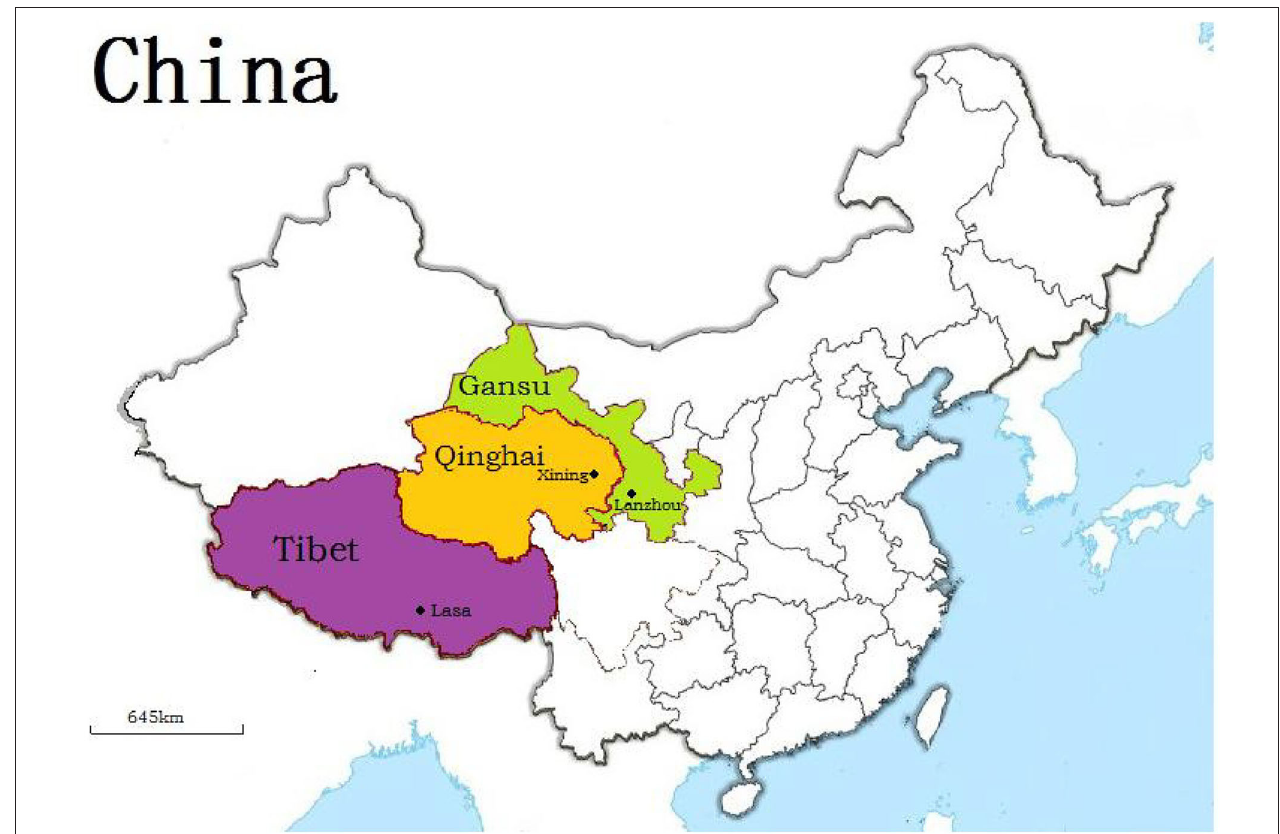
FIGURE 1 | Geographic distribution of yaks enrolled in